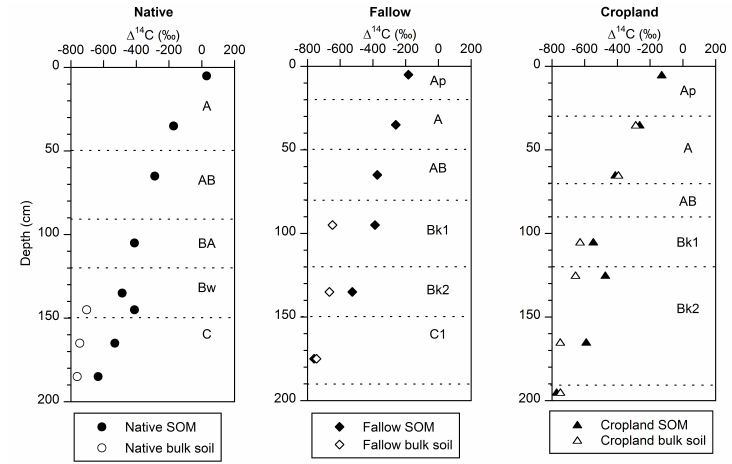
Figure 3. Distribution of ∆ 14 C values with depth under different sites.